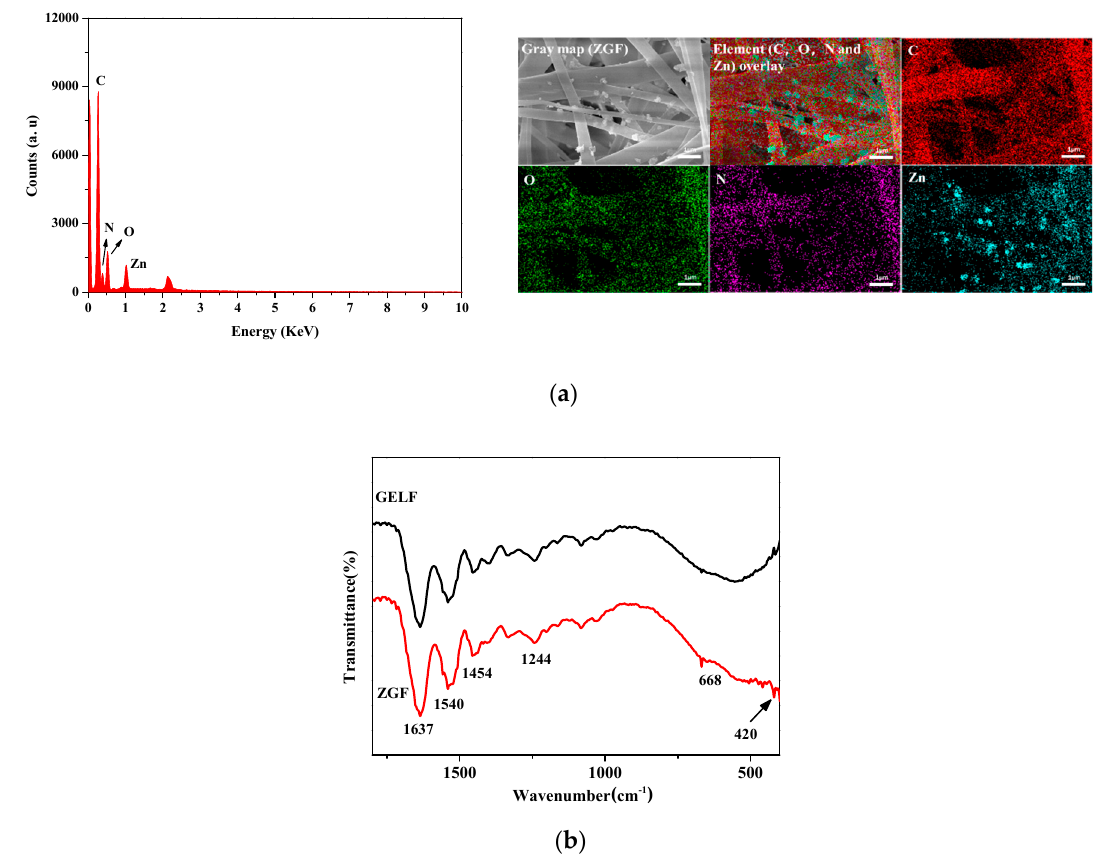
Figure 6. ( a ) EDX analysis of ZGF, ( b ) FTIR spectra of GELF and ZGF.